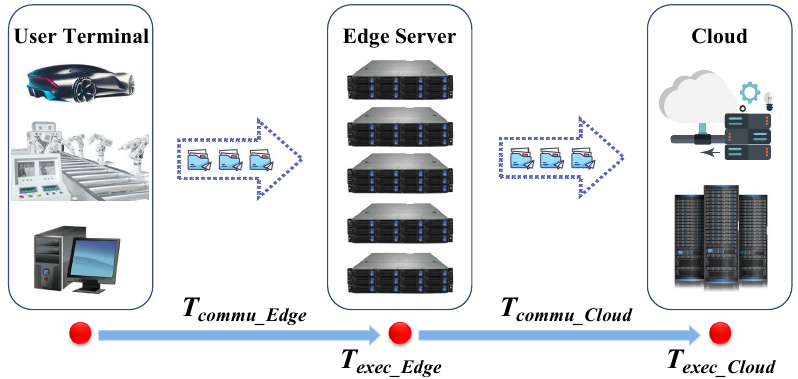
Figure 2. Task execution